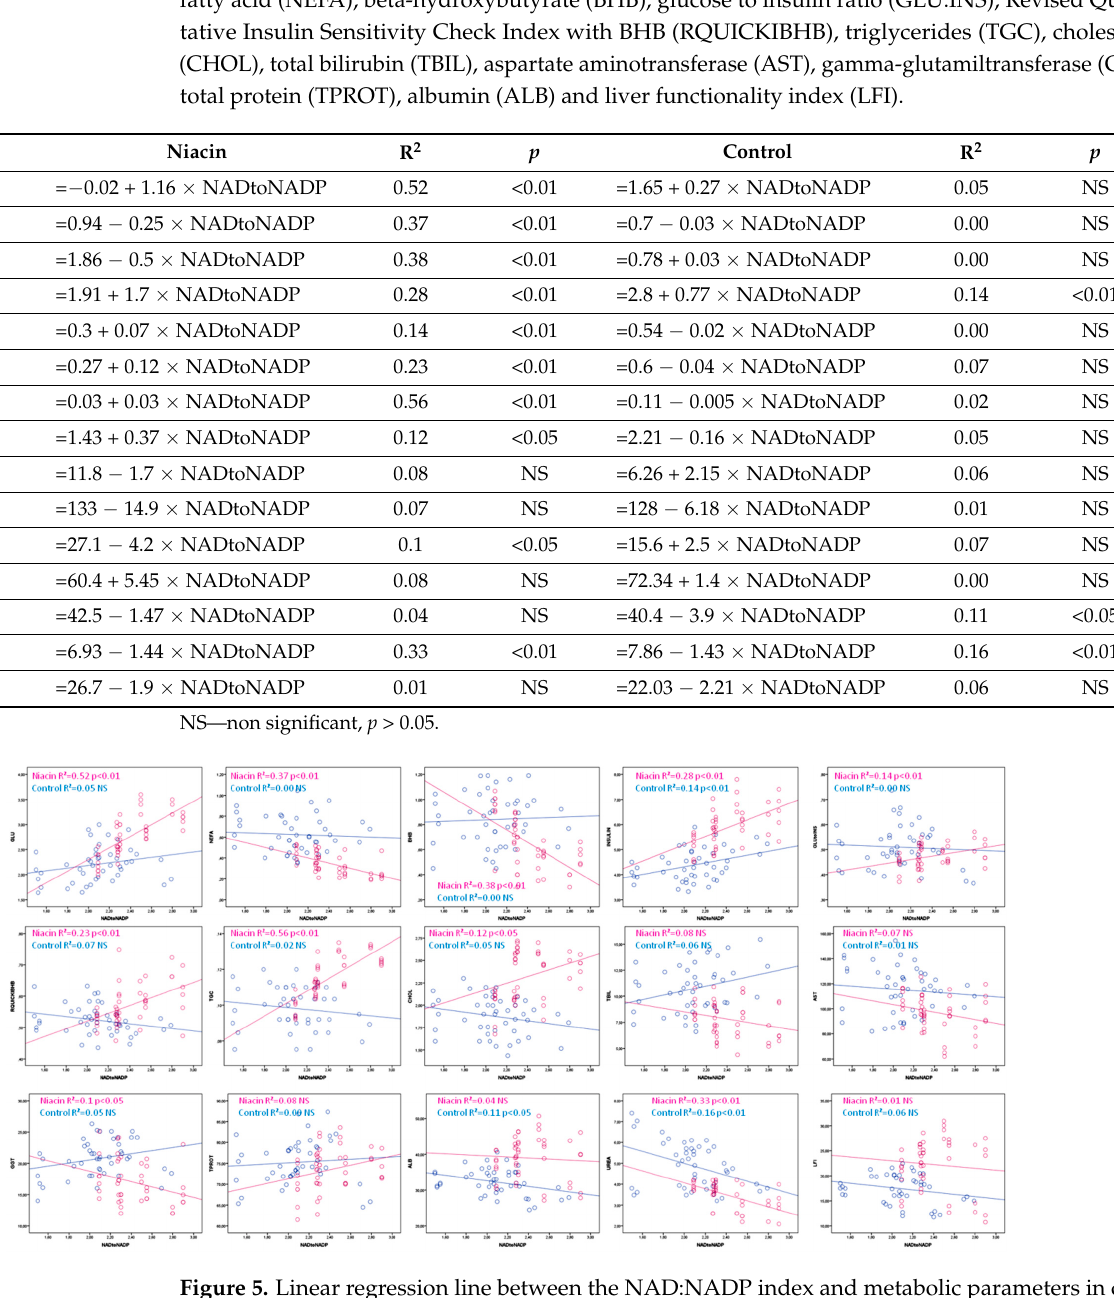
Table 4. Relationship of metabolic parameters with NAD:NADP values in cows that received and did not receive additional niacin. Abbreviations: Nicotinamide adenine dinucleotide to nicotinamide adenine dinucleotide phosphate ratio (NAD:NADP or NADtoNADP), glucose (GLU), nonesterified fatty acid (NEFA), beta-hydroxybutyrate (BHB), glucose to insulin ratio (GLU:INS), Revised Quanti- tative Insulin Sensitivity Check Index with BHB (RQUICKIBHB), triglycerides (TGC), cholesterol